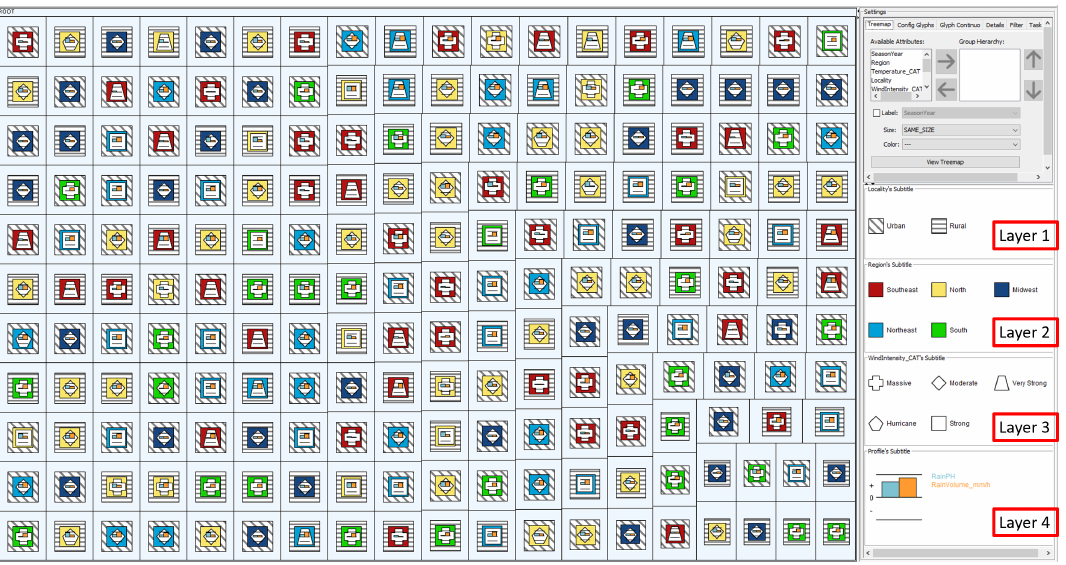
Figure 8. Scenario Glyphs (G) visualization configured for one of the user tasks. This visualization uses no Treemap hierarchy; the absence of hierarchy is replaced by categorical glyphs.